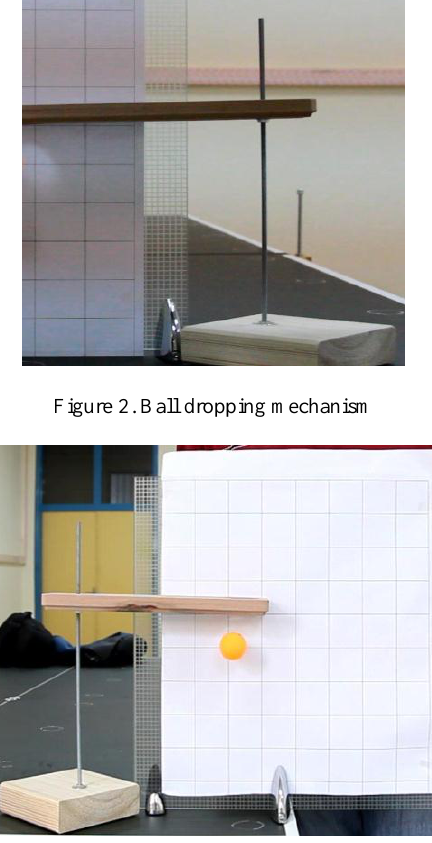
Figure 3. Control grid for measurement